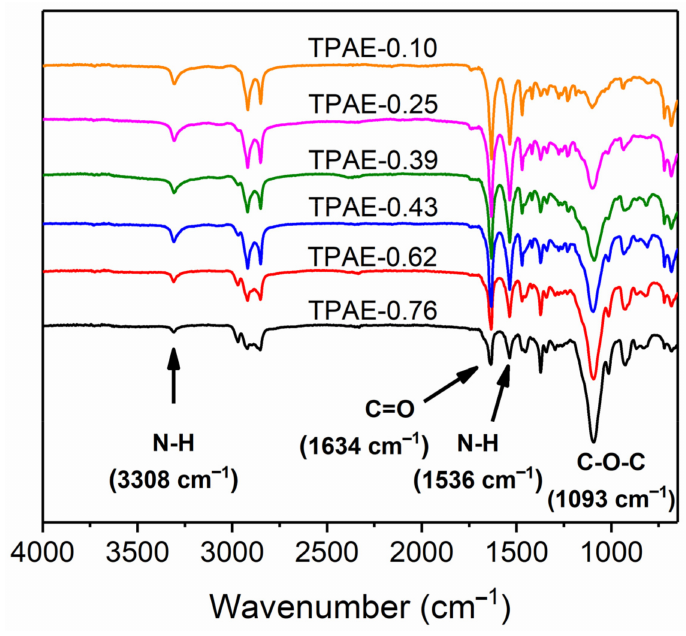
Figure 3. FT-IR spectra of TPAEs.